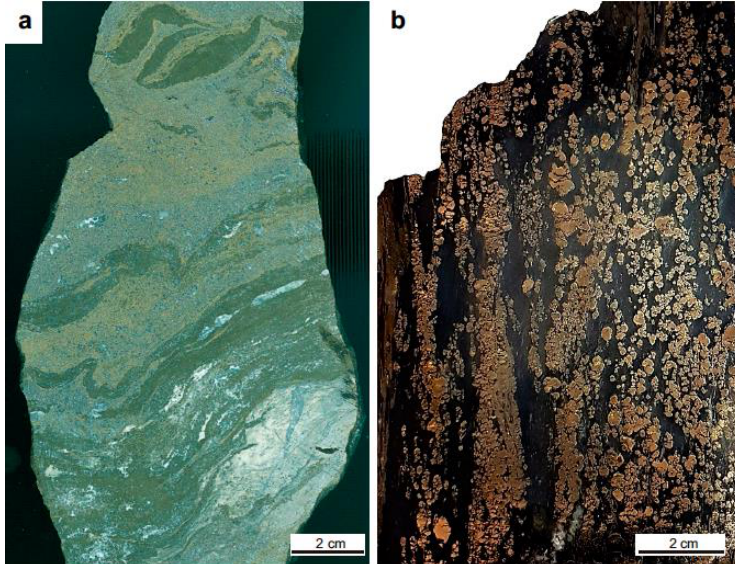
Figure 2. Massive sulfides generated by replacement of: ( a ) volcaniclastic rocks replaced by polymetallic sulfides, from Aguas Teñidas, showing of dacitic volcanic rocks embedded and corroded by sulfides. The banded facies show an original slumping fold, including very thin bands of sedimentary pyrite bearing shale. Coarse sized bands correspond to porous volcaniclastic beds pervasively replaced by sulfides (i.e.,: Galena, sphalerite, pyrite and chalcopyrite) and carbonates; and ( b ) black shales from Cueva de la Mora, where pyrite aggregates pervasively replace the rock.